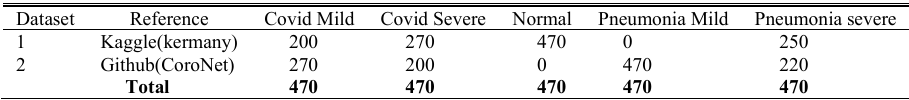
TABLE 1 IMAGE DISTRIBUTION